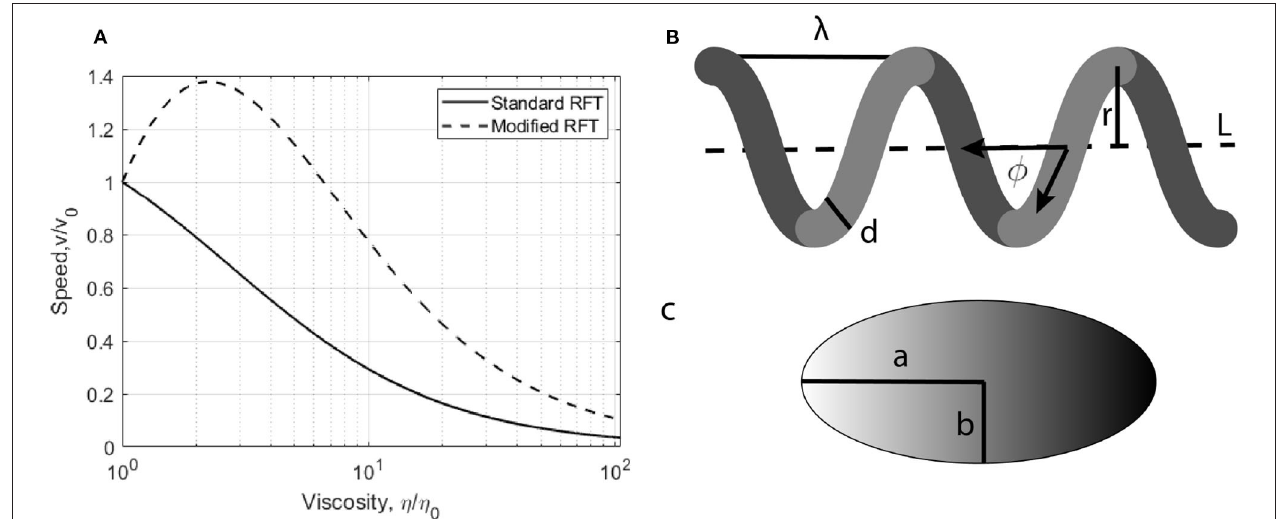
FIGURE 1 | (A) Predicted changes in free swimming speeds as viscosity is increased calculated using standard and modified RFT. (B,C) Typical geometry of an E. coli . The body is modeled as a ellipsoid of major axis a and semi major axis b. Its propulsive helical filament, the flagella, is modeled as a helix of pitch length λ , radius r, width d, pitch angle φ , and length